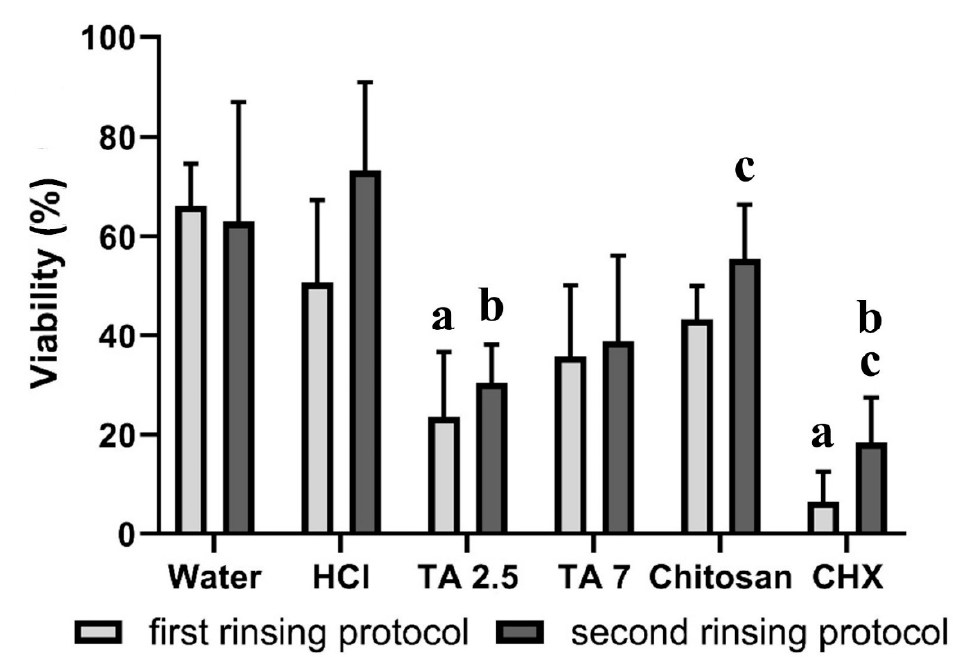
Figure 5. Viability of bacteria in (%). The height of the bars corresponds to the mean value, and the line applied corresponds to ± the standard deviation. During two days of biofilm formation on bovine enamel specimens in situ, the subjects rinsed 4 or 5 times with di ff erent experimental solutions. By using two di ff erent rinsing protocols, the immediate and long-lasting e ff ects were tested. For the ex-vivo examination with a fluorescence microscope, the biofilm was stained with LIVE / DEAD ® BacLight ™ . Friedmann test: p < 0.05. Mouthwashes that di ff er significantly from water are marked with a for the first and b for the second protocol. Wilcoxon Test: p < 0.05. Significant di ff erences between both rinsing protocols are marked with c. HCl = hydrochloric acid, TA 2.5 = tannic acid (pH = 2.5), TA 7 = tannic acid (pH = 7) and CHX = chlorhexidine.